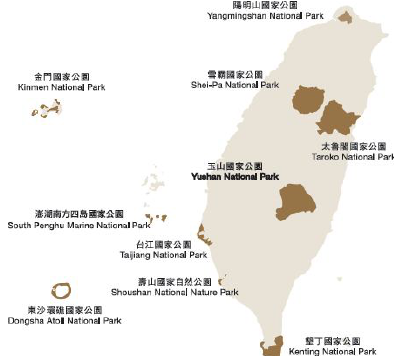
Figure 1. The distribution of nine national parks in